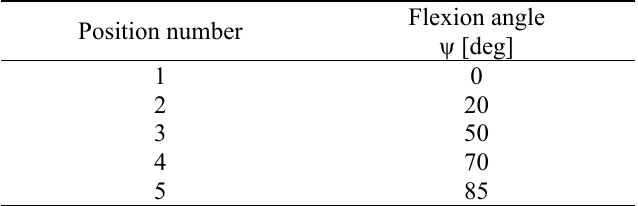
Table 1. Degrees of flexion